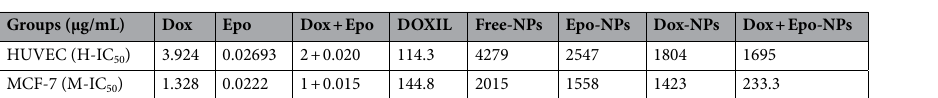
Table 4. IC 50 values of all HUVECs and MCF-7 cells groups incubated for 24 h.